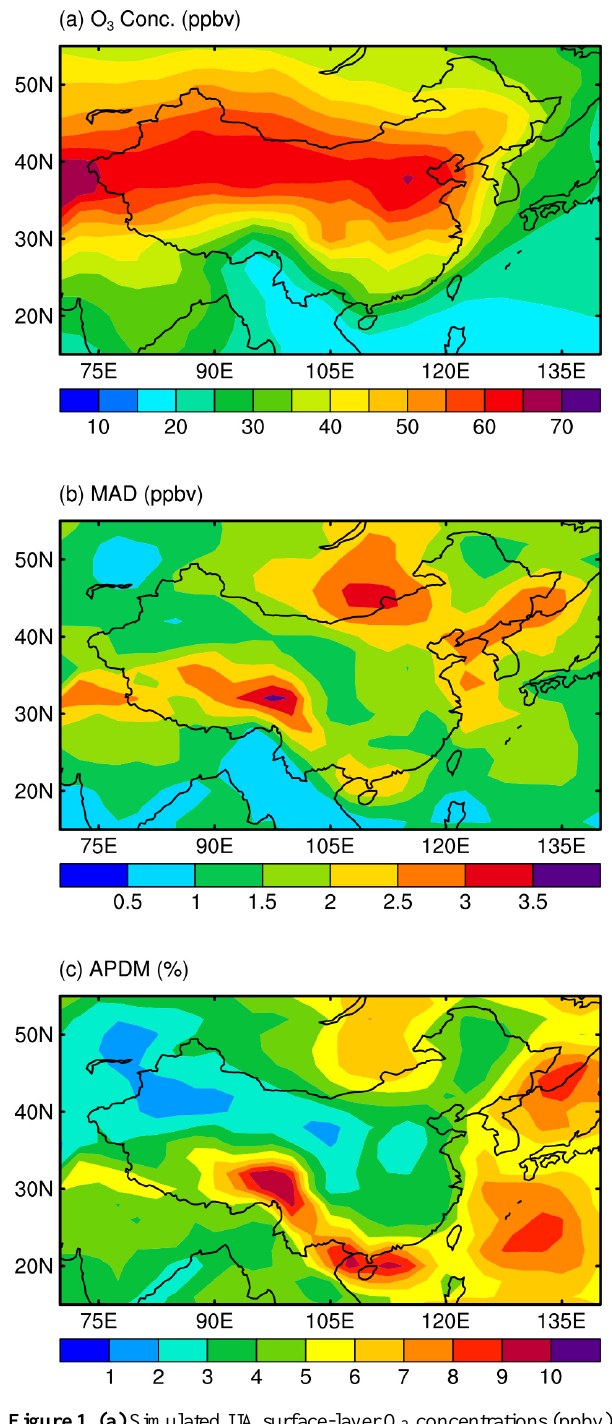
Figure 1. (a) Simulated JJA surface-layer O 3 concentrations (ppbv) that are averaged over years 1986–2006 of simulation O 3 _TOT. (b ) MAD (ppbv) and (c) APDM (%) calculated with the 1986–2006 simulation of O 3 in O 3